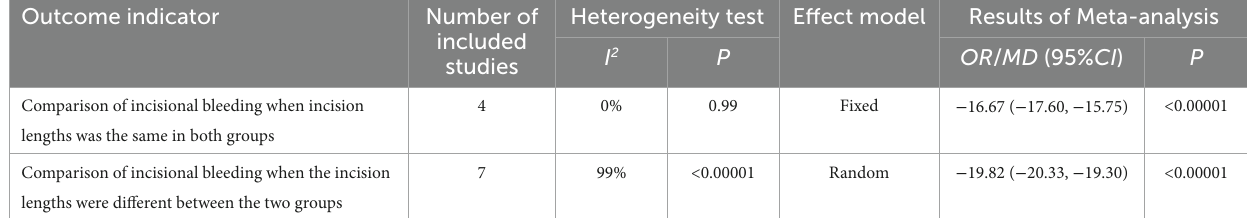
TABLE 3 Results of subgroup analysis comparing incisional bleeding in the two groups. Outcome indicator